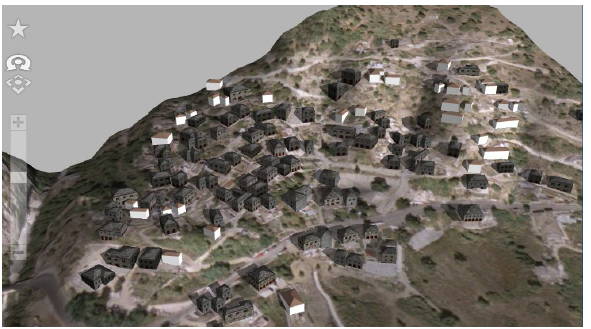
Figure 15. 3D models with shadow